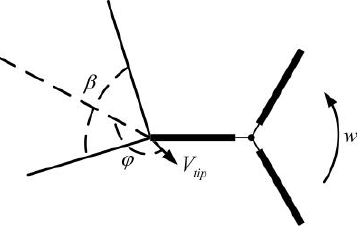
Figure 2. Micro-motion model.